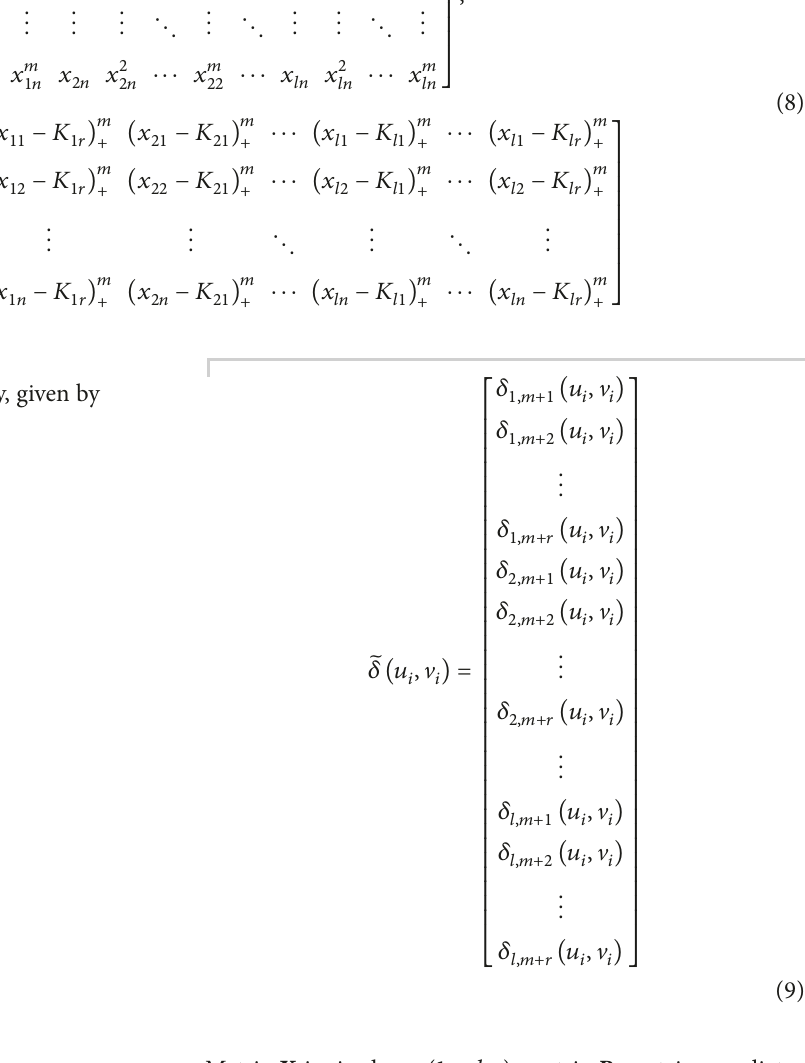
̃𝛽(𝑢 , V ) 𝑖 𝑖 ̃𝛿(𝑢 , V ) is a 𝑖 𝑖